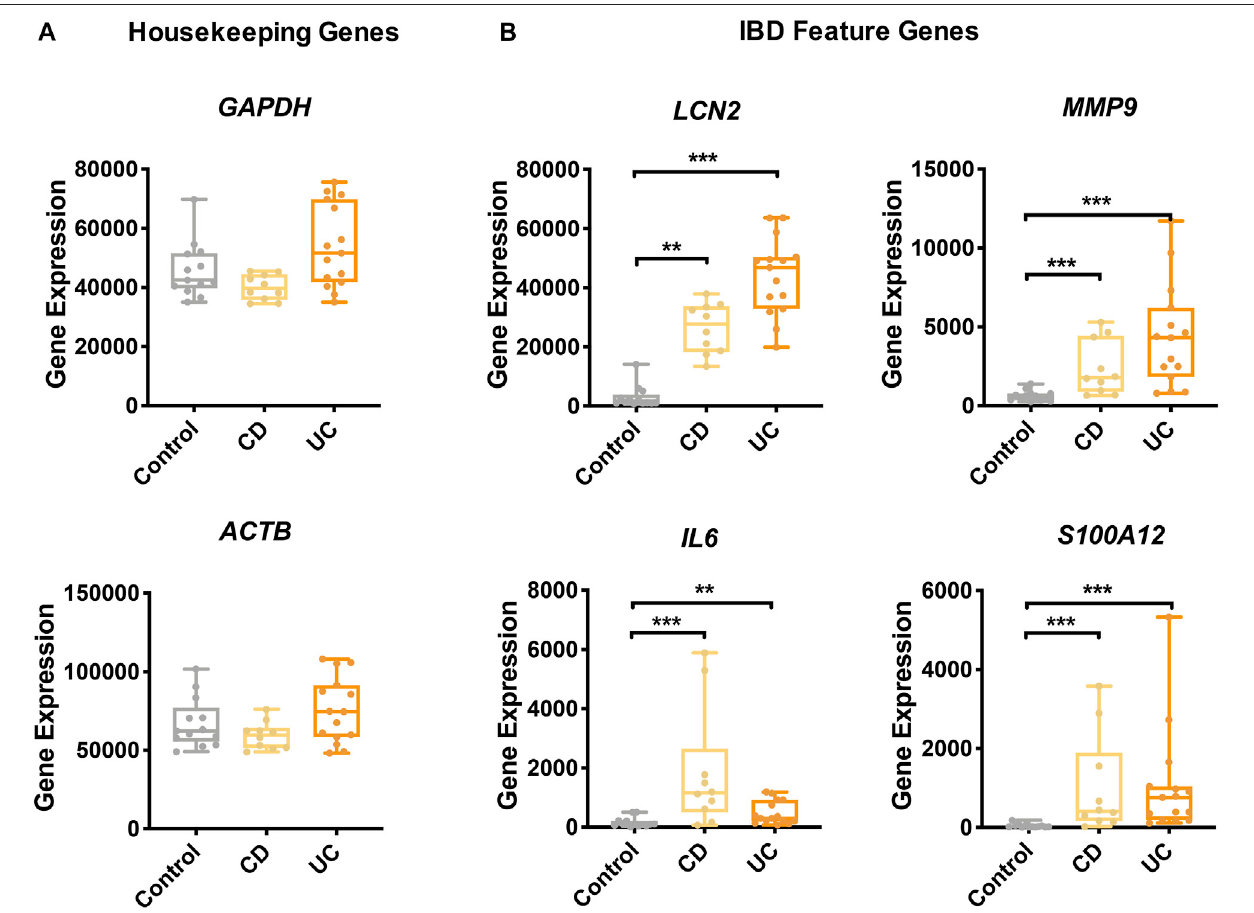
FIGURE 2 | Gene expression of IBD feature genes and housekeeping genes. The expression of housekeeping genes (A) and feature genes of IBD (B) was compared among the study groups. Yellow, CD; orange, UC; gray, control. Data are presented as mean ± standard error. *: p < 0.05, **: p < 0.01, ***: p < 0.001, Dunnett ’ s